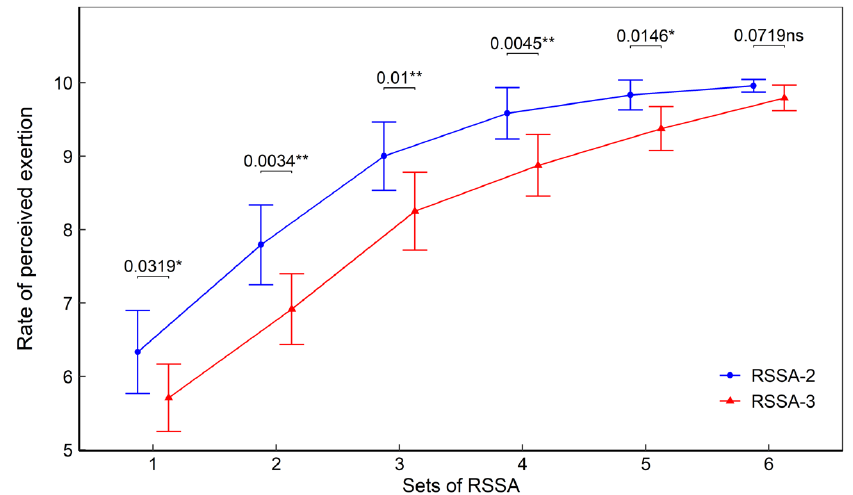
Figure 5. Rate of perceived exertion in RSSA-2 and RSSA-3 tests (** p < 0.01; * p < 0.05, ns—non-significant).